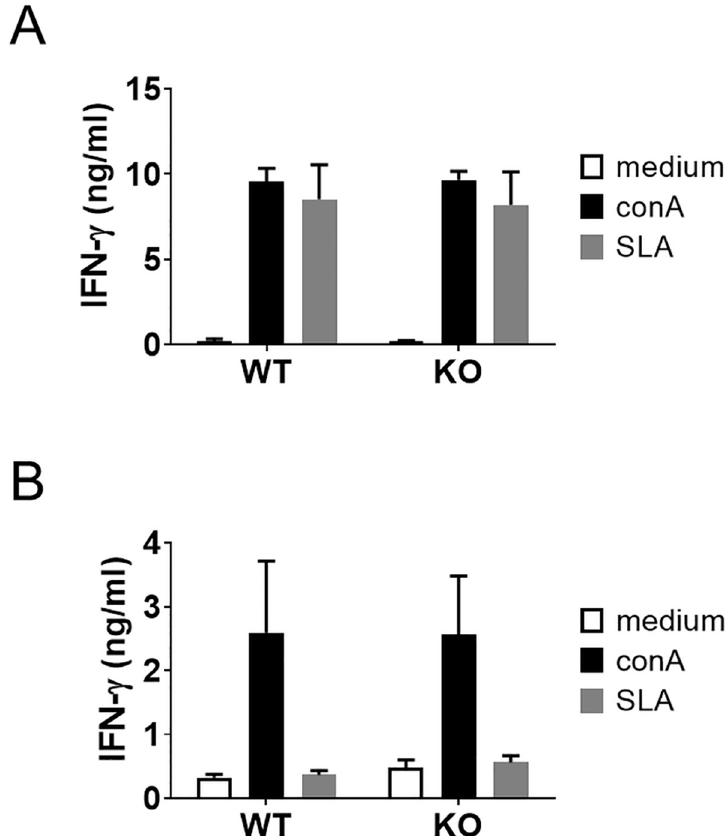
Fig 4. Little influence of MRP14 depletion on antigen-specific T cell responses during Leishmania infection. WT (n = 5) and MRP14KO mice (n = 5) were infected with L . major (A) or L . donovani (B). Splenocyte from the infected mice were either left unstimulated or stimulated with con A or SLA in vitro. After 72 hours, the supernatants were collected and measured for IFN- γ levels by sandwich ELISA Mean and SD of each group are shown. These are a representative of two or three independent experiments with similar